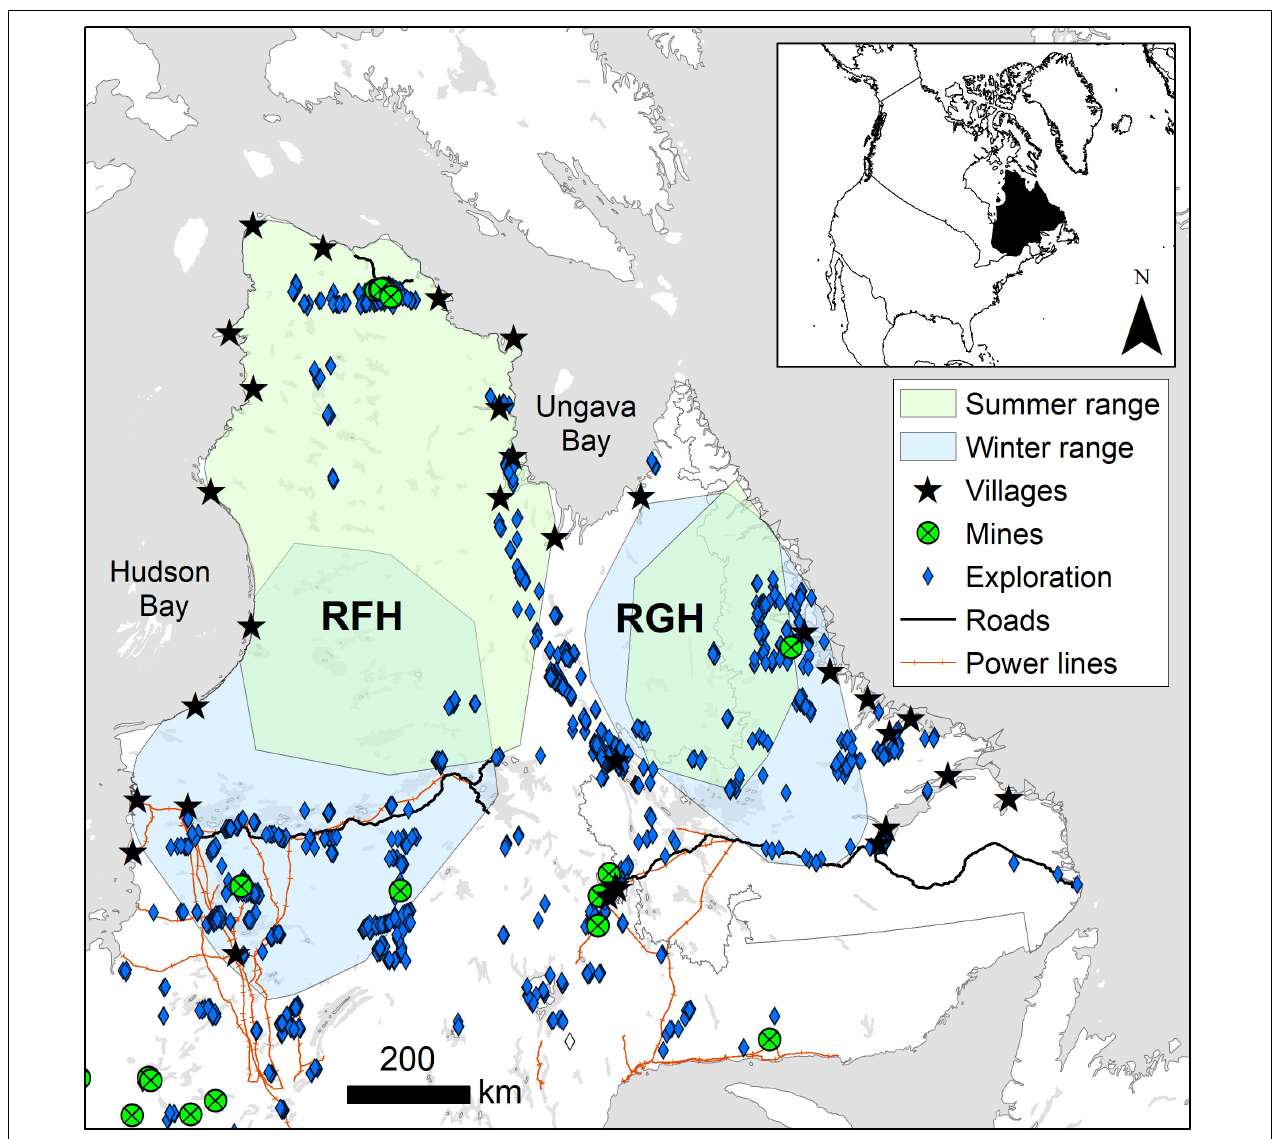
FIGURE 2 | Winter and summer ranges of eastern migratory caribou of the Rivière-aux-Feuilles (RFH) and Rivière-George herds (RGH) and distribution of human disturbances in northern Québec and Labrador, Canada